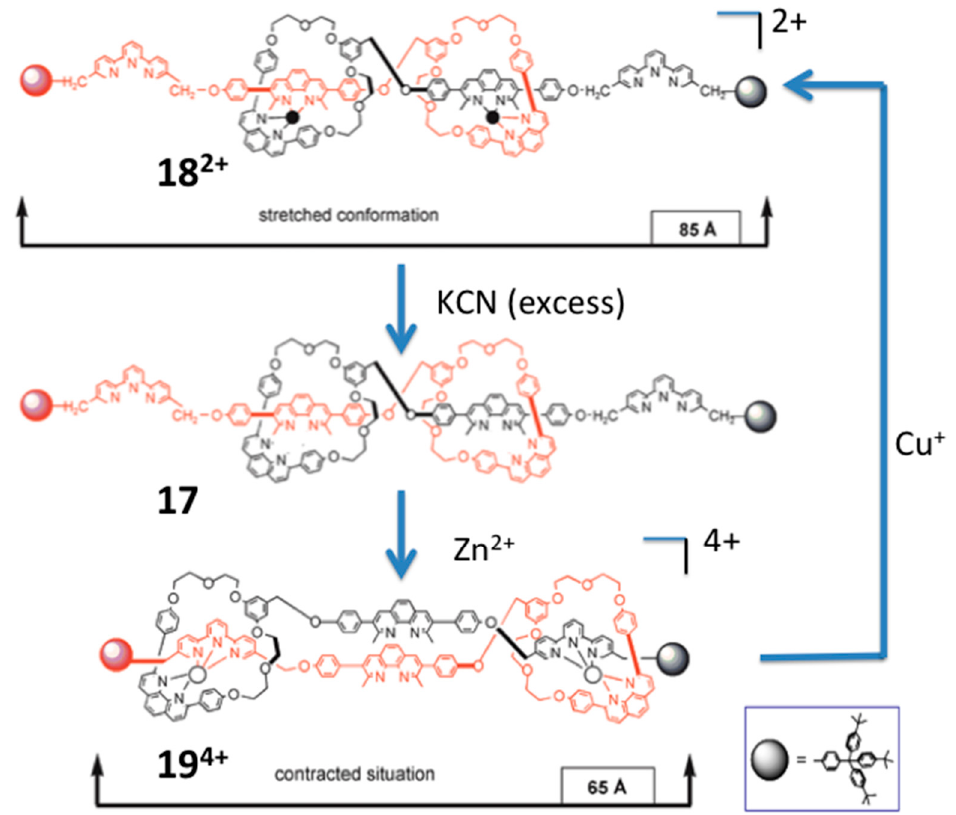
Figure 18. A terpyridyl and phenanthrolyl-containing rotaxane can switchably bind Cu + and Zn 2+ , resulting in extension and contraction, respectively. Adapted with permission from Reference [81]. Copyright (2003) the Royal Society of Chemistry.